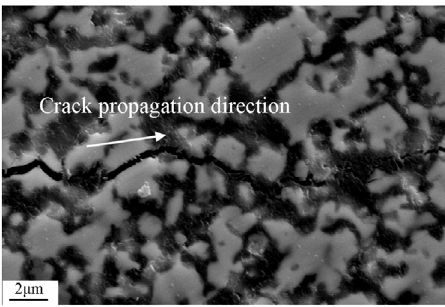
Fig. 6 Secondary electron image of crack propagation path in BYb50